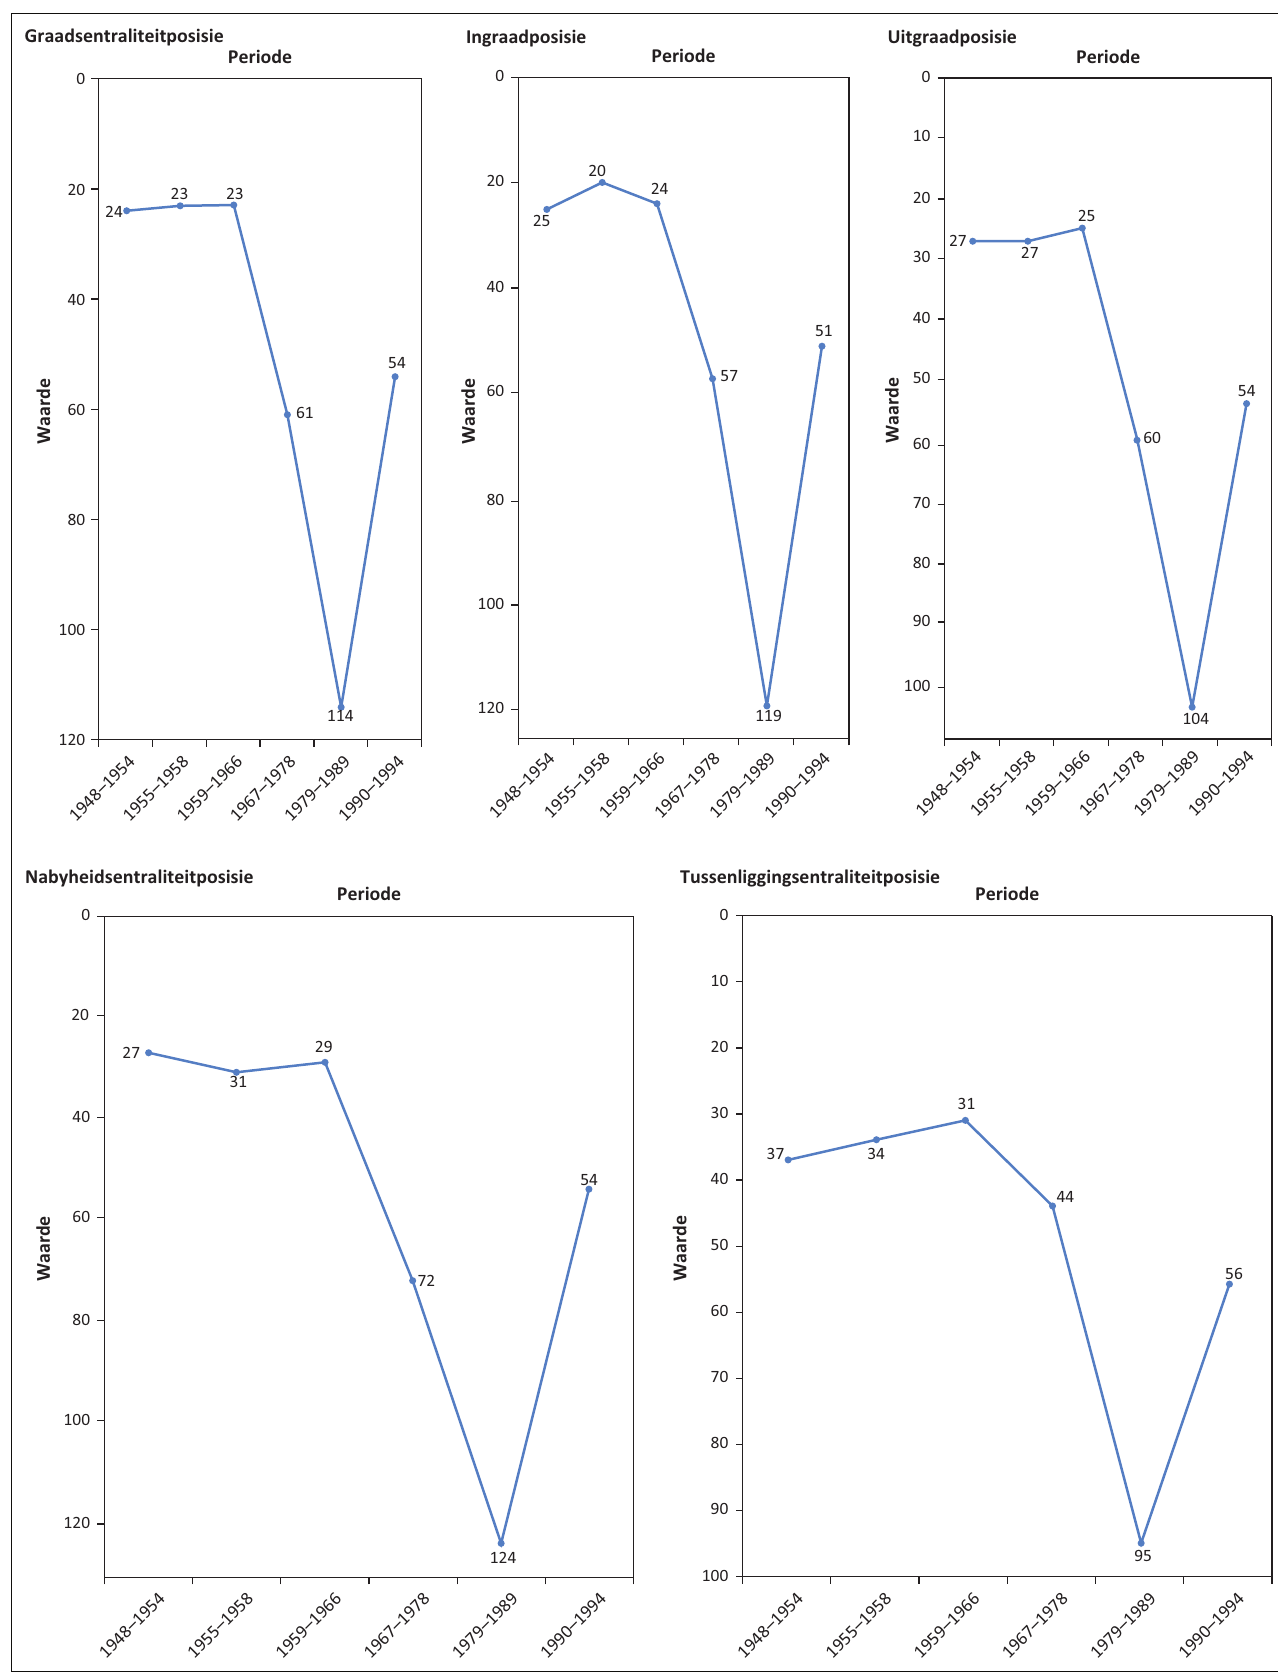
FIGUUR 3: Suid-Afrika se veranderende posisie ten opsigte van